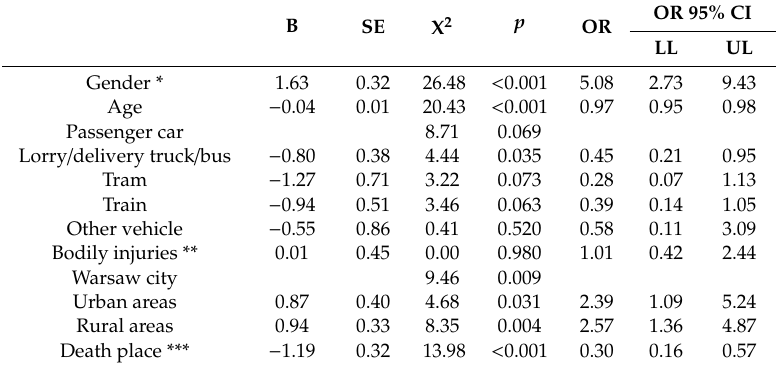
Table 9. Results of the logistic regression analysis testing the predictors of death in a road accident among pedestrians under the influence of alcohol. B